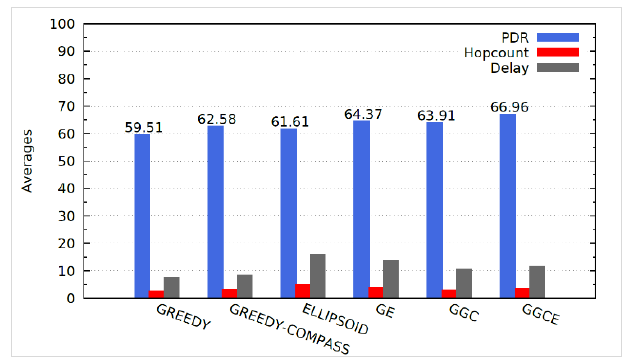
Figure 4. The 1000s duration (1047 flows) performances for the greedy and the multi-greedy forwarding